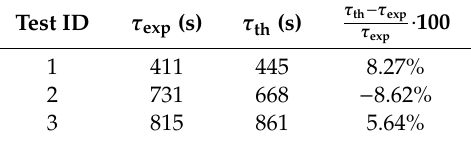
Table 4. Experimental and theoretical average residence times for the studied